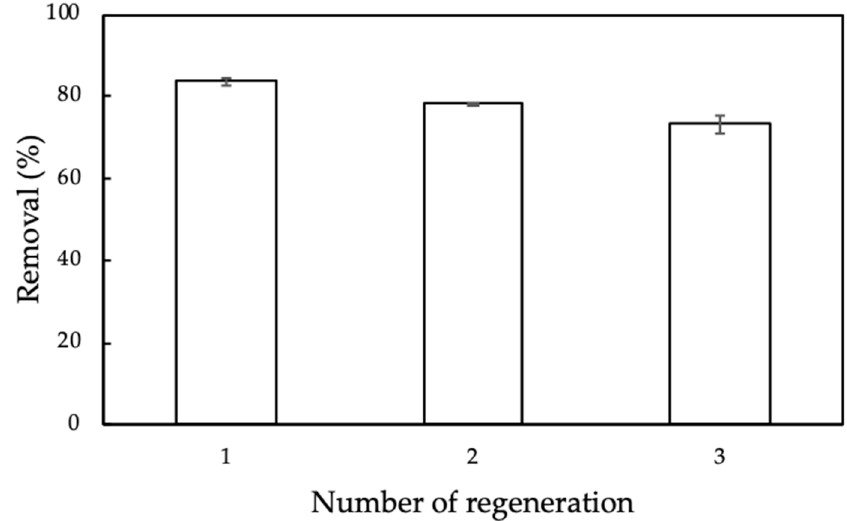
Figure 16. Removal of CFX using protein-modified nanosilica (ProMNS) after three regenerations. Error bars show standard deviations of two replicates.